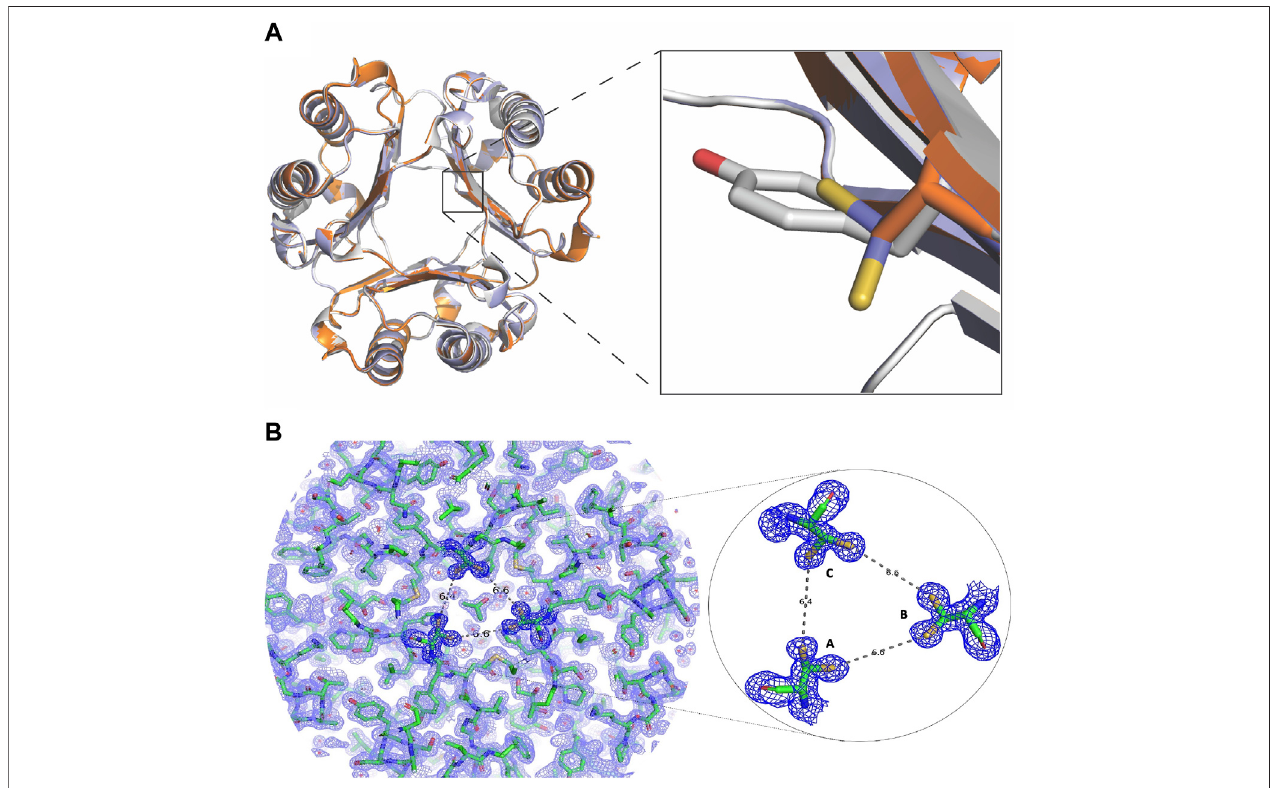
FIGURE 3 | Changes in the MIF structure with mutations at Tyr99 (A) The crystal structure of Y99C MIF has two thiol group conformations per monomer in the solvent channel (PDB: 7KQX). The inset shows overlapping side chains for residue 99 in WT MIF (3DJH; gray) and the Y99C (7KQX; blue) and Y99A (5EIZ; orange) MIF variants (B) ElectrondensitymapforMIFY99Chomotrimer.Ontheleft,the2Fo-FcelectrondensitymapfortheY99CMIFhomotrimerisshown.Ontheright,the2Fo-Fc map and thetwo conformations for thethiolgroups ofY99Care enlarged. Thedistancesamong the closest sulfur atoms from each subunit areover 6 Åapartand too far from each other to form disul fi